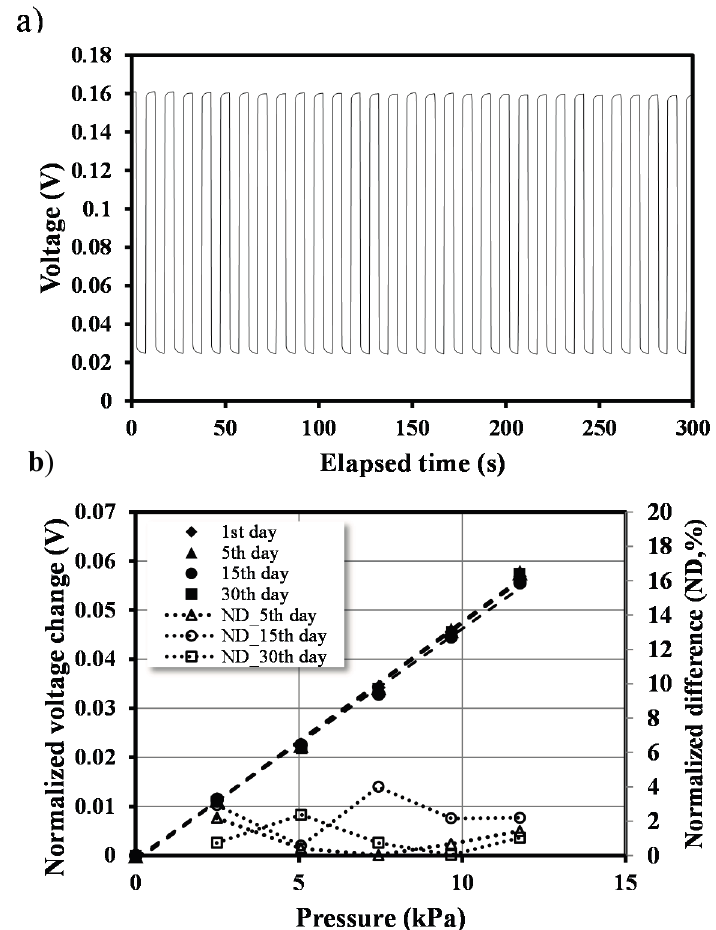
Figure 4. Long-term stability test. ( a ) Pressure of 30 kPa is repeatedly applied to the microfluidic channel using a pneumatic pump at a 5-s interval; ( b ) Calibration is conducted four times for 30 days, and the normalized difference between the initial data and the data measured each day is less than